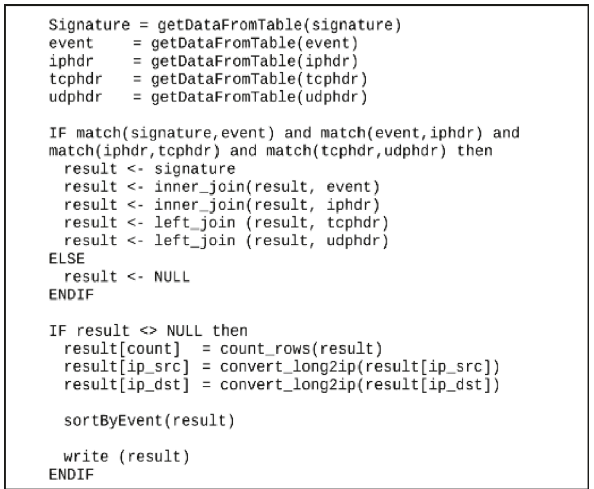
Figure 7: Pseudocode for performing stages in identifying the attacks